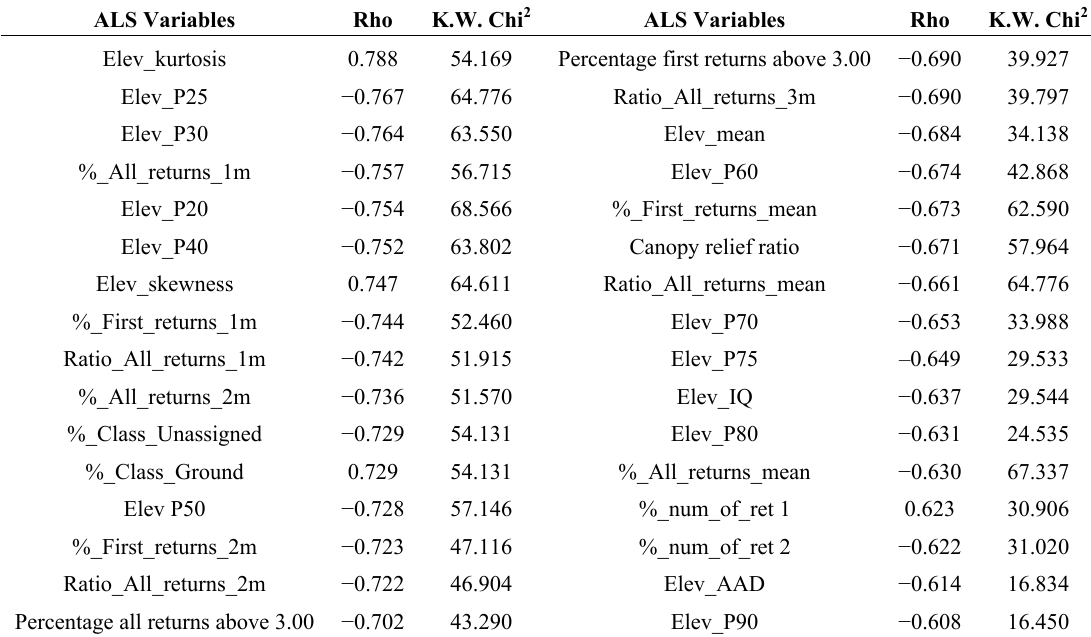
Table 5. Spearman’s coefficient (Rho) and Kruskal–Wallis (K.W.) chi-square values for selected variables with a statistical significance level p -value ≤